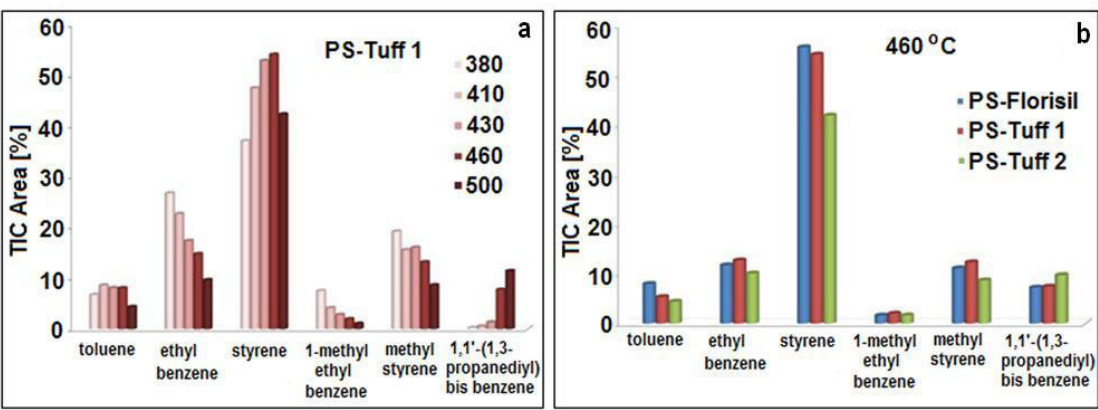
Figure 8. Distribution of compounds (TIC area, %) from liquid products obtained by thermal degradation of PS in presence of Tuff 1